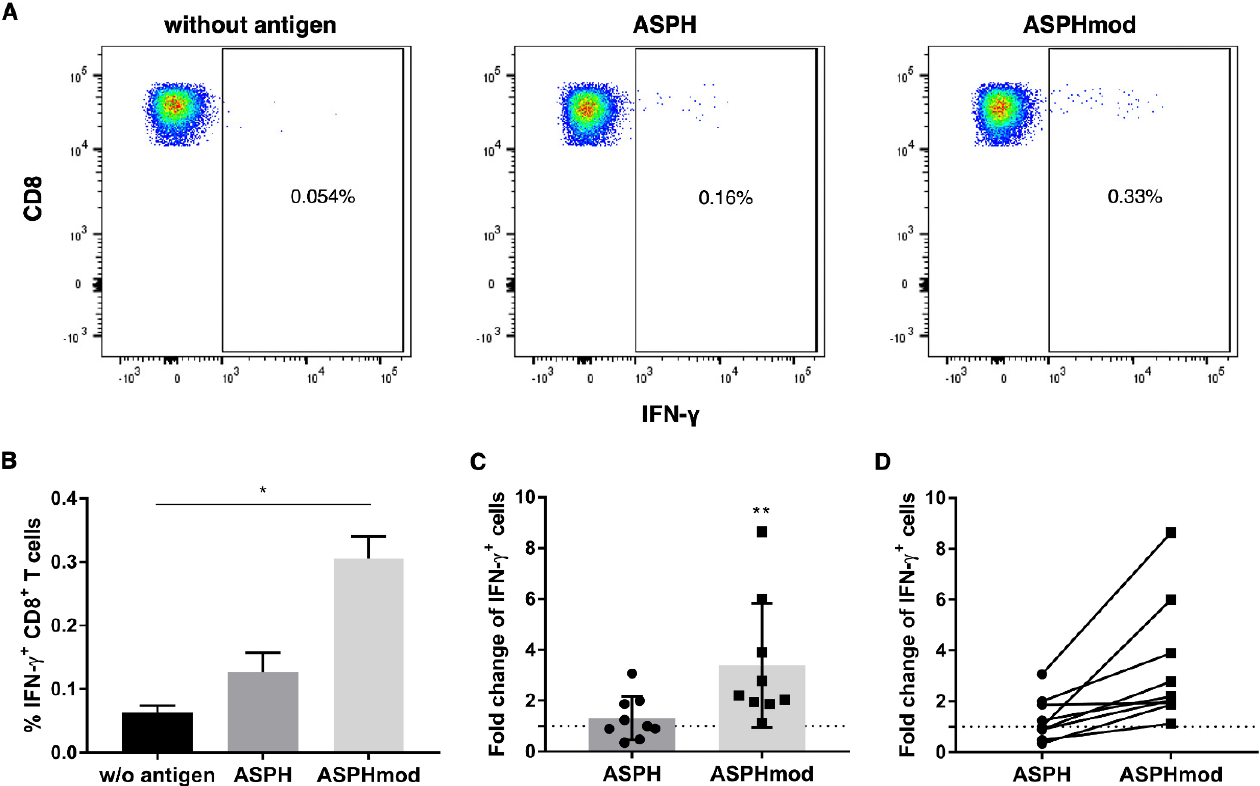
Figure 5. ASPHmod-pulsed moDCs stimulate an increased number of CD8 + IFN- γ + T cells. ( A ) Rep- resentative flow cytometric analysis of a single individual. ( B ) Data represent the means ± SD of the same individual assessed in triplicate: * significantly different, p < 0.05 (Kruskal–Wallis test). ( C ) Fold change in CD8 + IFN- γ + T cells relative to cells restimulated with the non-pulsed moDC control. Data represent the means ± SD of nine individuals: ** significantly greater, p < 0.01 (Mann–Whitney test). ( D ) Relative T cell response of each individual to ASPH- versus ASPHmod-pulsed moDCs.